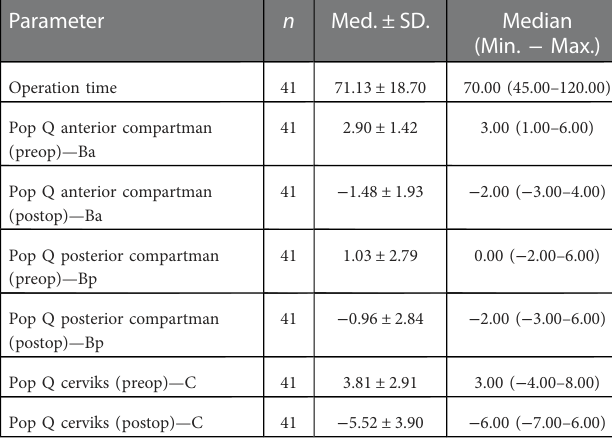
TABLE 2 The mean, standard deviation, median, minimum, and maximum values of the medical and sociodemographic characteristics of the patients measured as continuous variables.